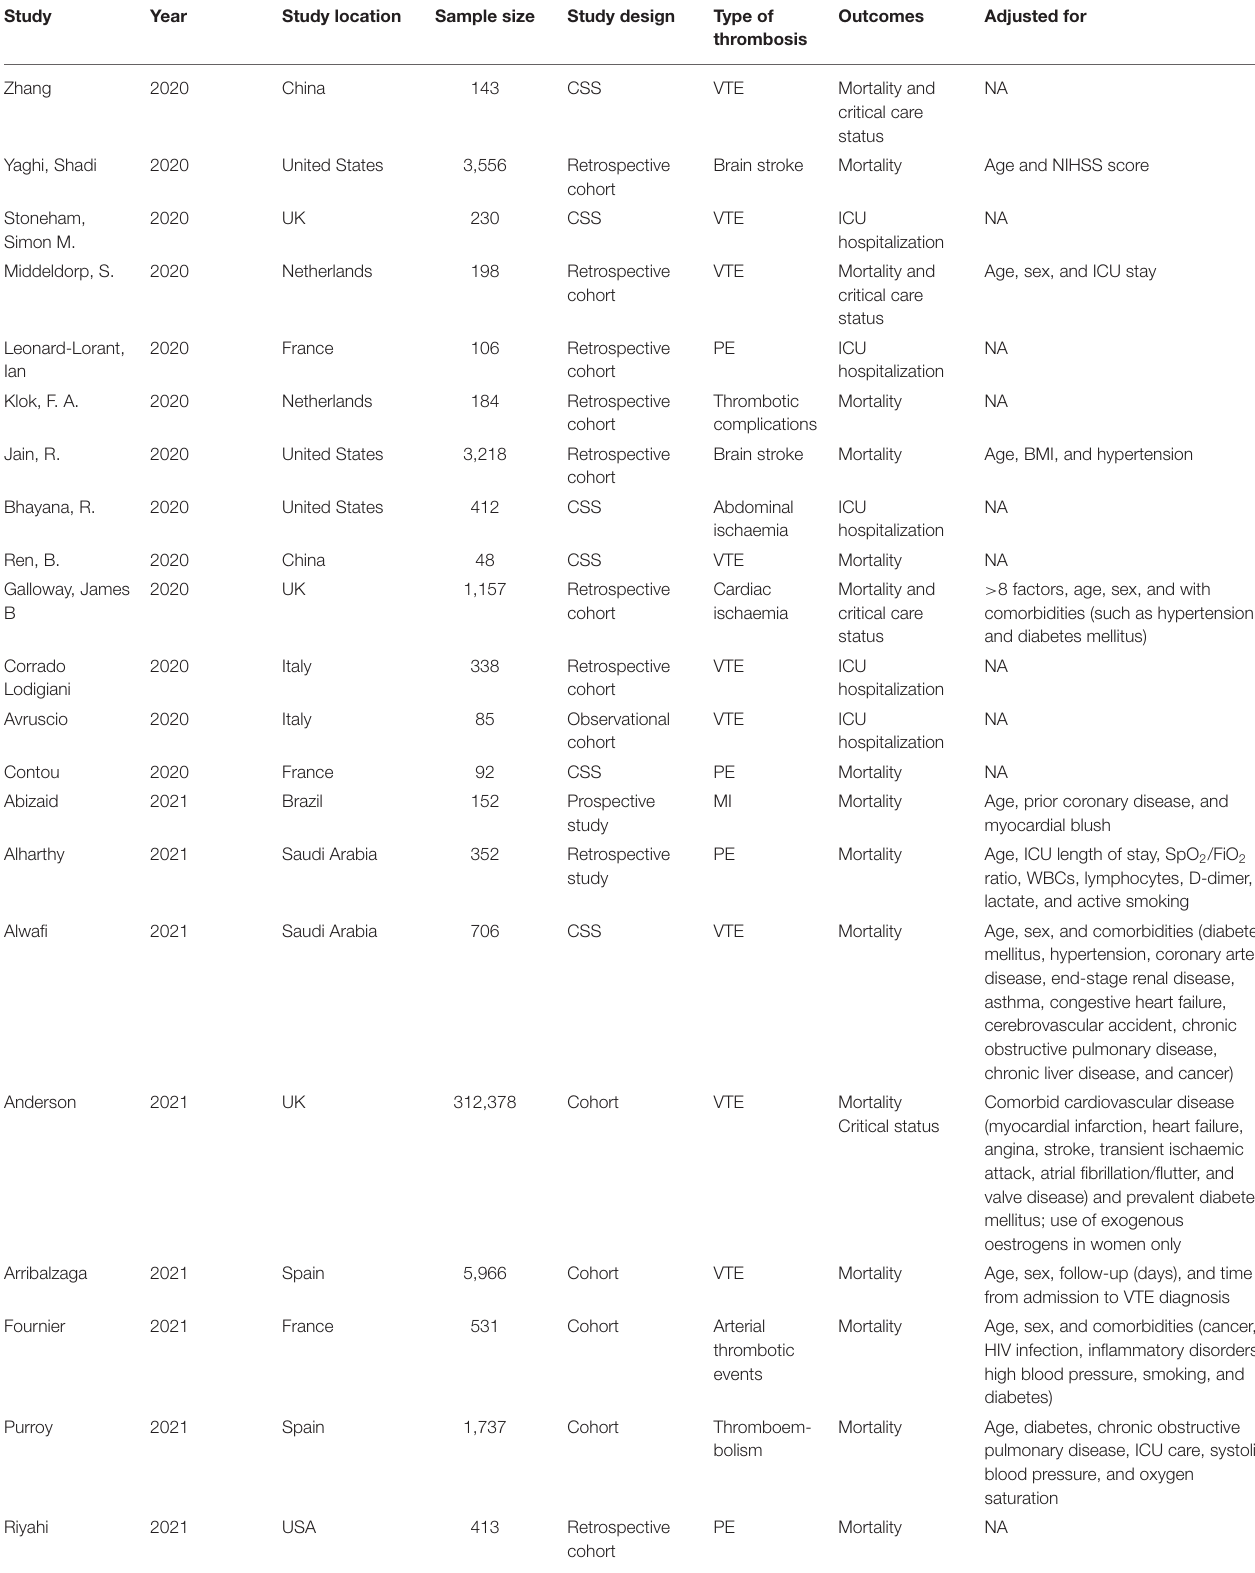
TABLE 1 | Characteristics of the included